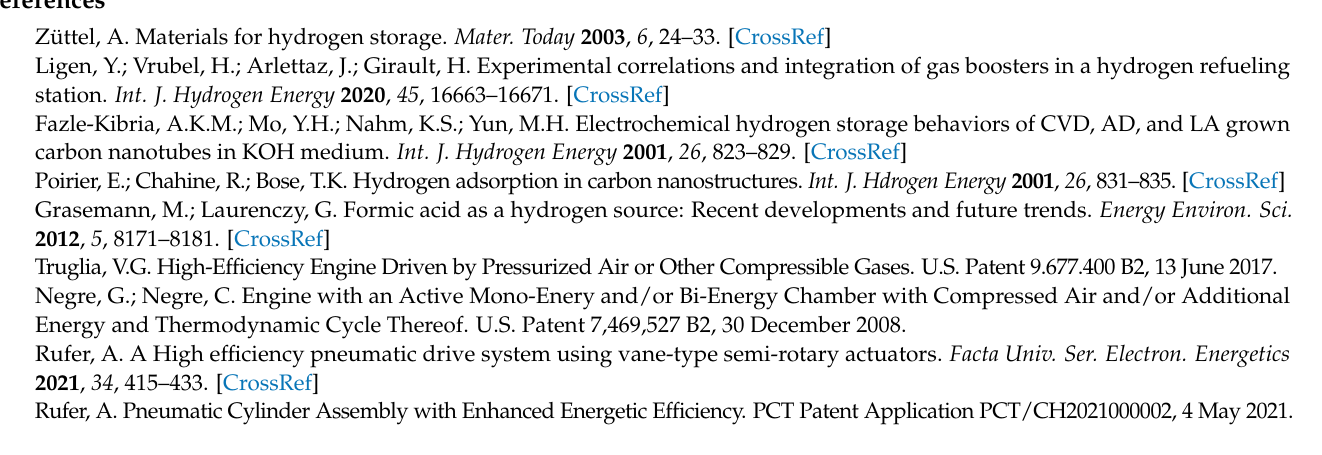
Figure 24. Voltage of the storage capacitor (V).